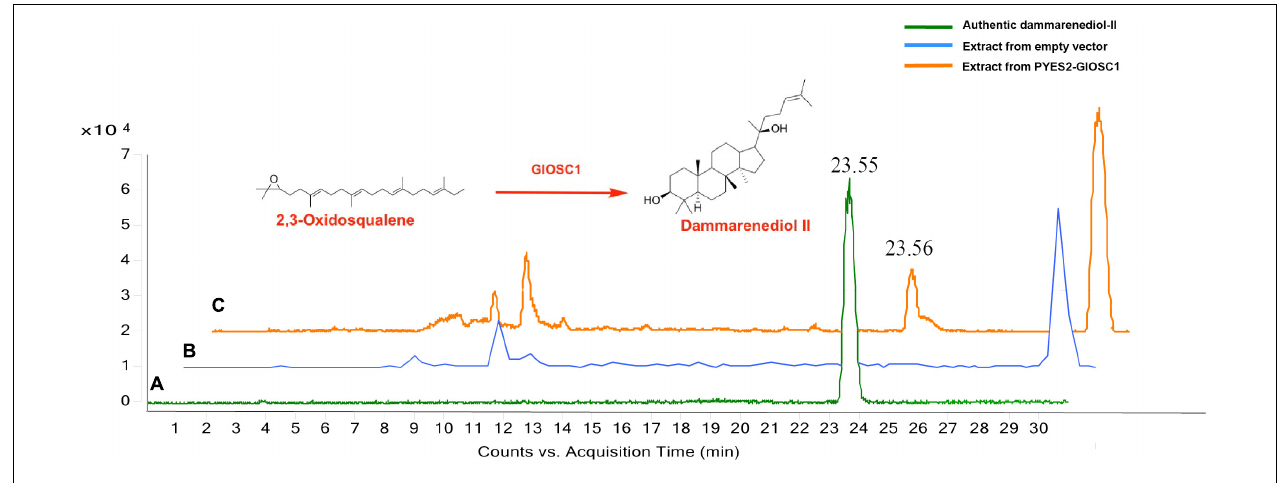
FIGURE 7 | Three chromatograms of the analysis: (A) authentic dammarenediol II, (B) the extracts of the yeast with empty vector, and (C) dammarenediol II biosynthesized by GlOSC1 in